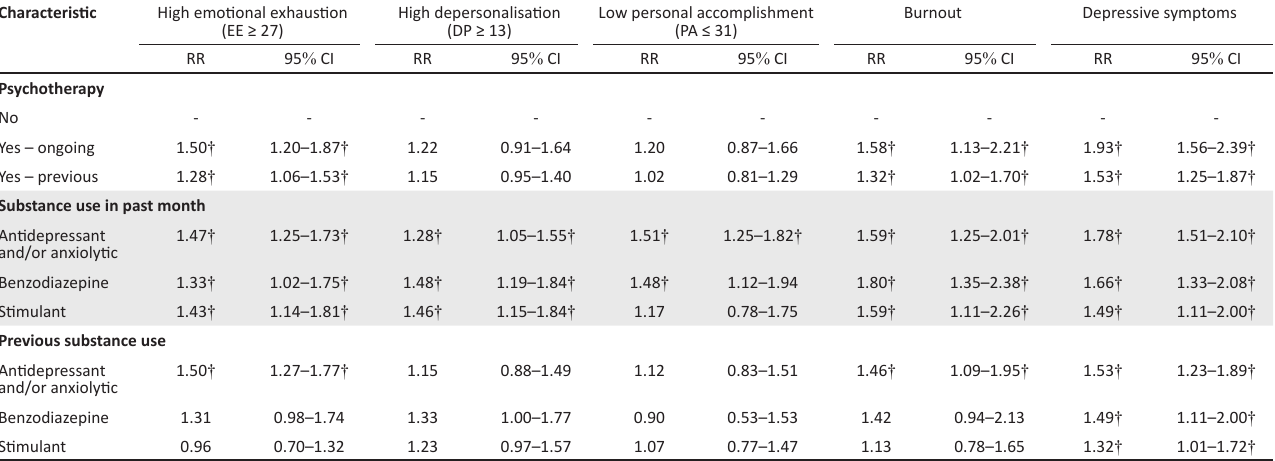
TABLE 3: Univariable analysis of risk factors for burnout and depressive